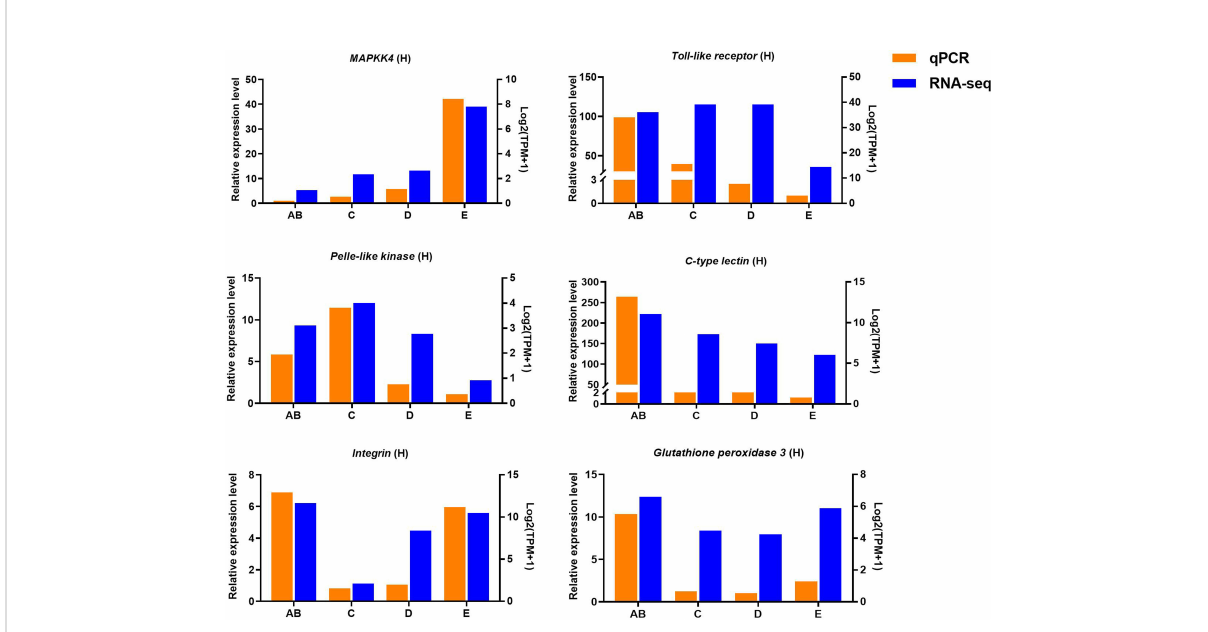
FIGURE 10 Quantitative expression of six genes was determined by qPCR in hepatopancreas from different molting stage of P. trituberculatus . MAPKK4: mitogen-activated protein kinase kinase 4